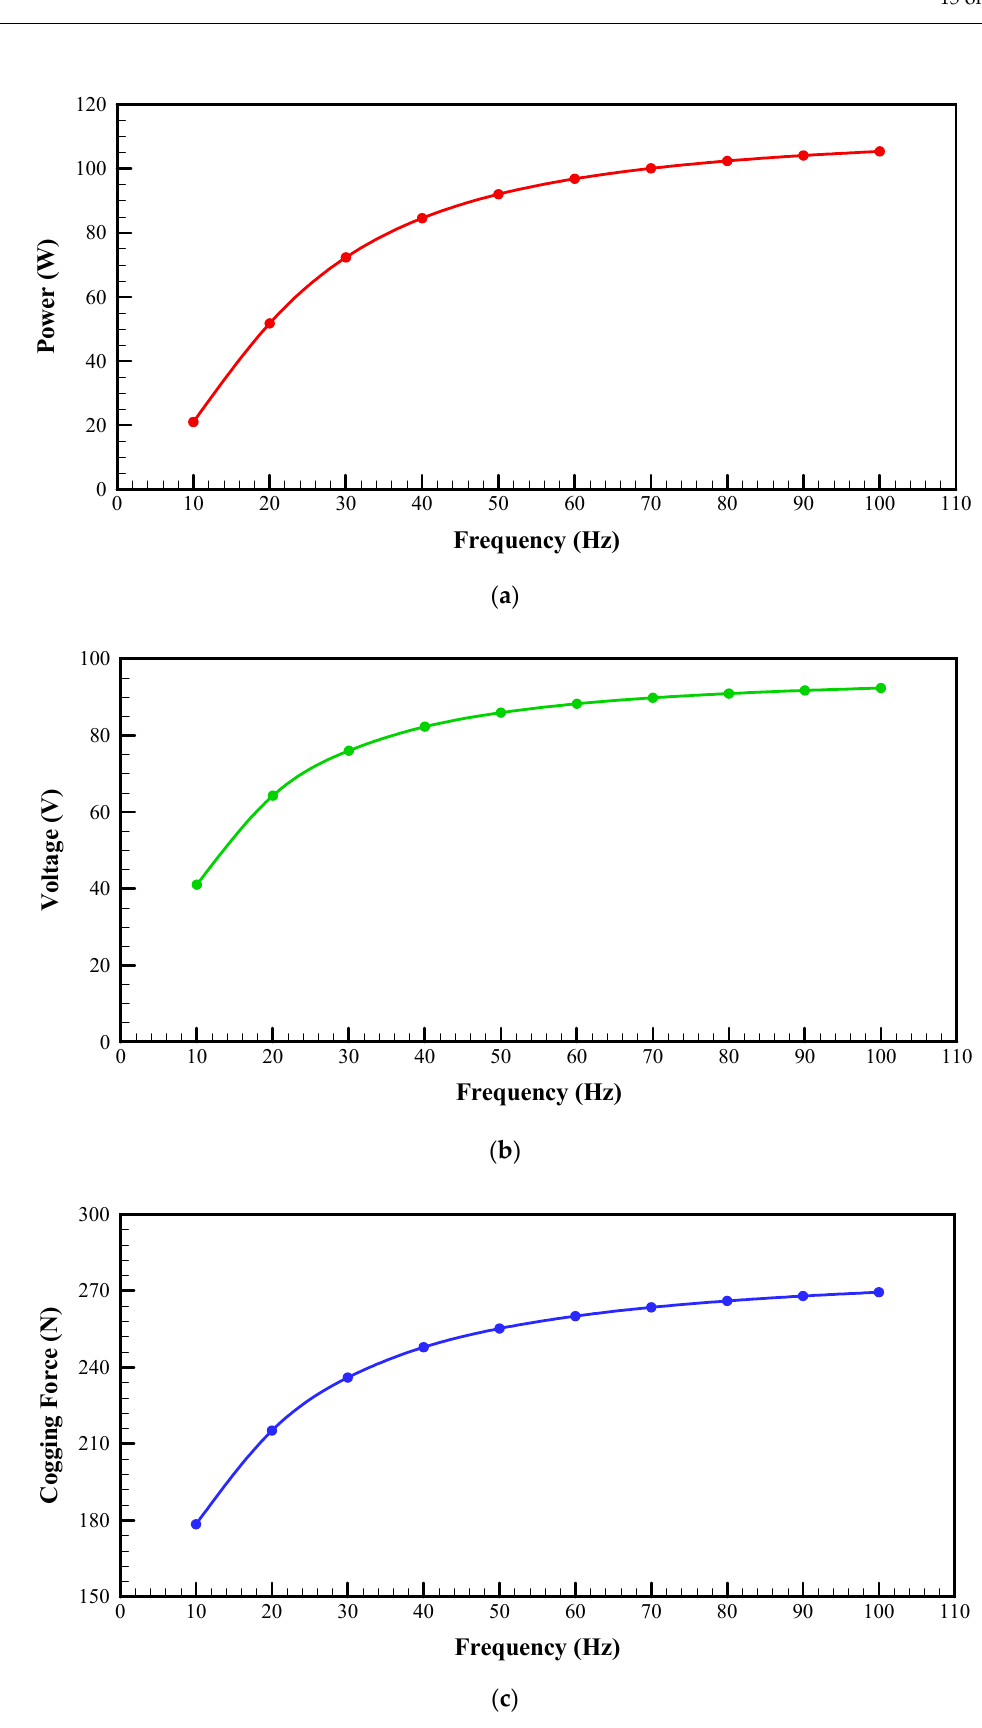
Figure 11. Influence of frequency on ( a ) power, ( b ) voltage, and ( c ) cogging force.